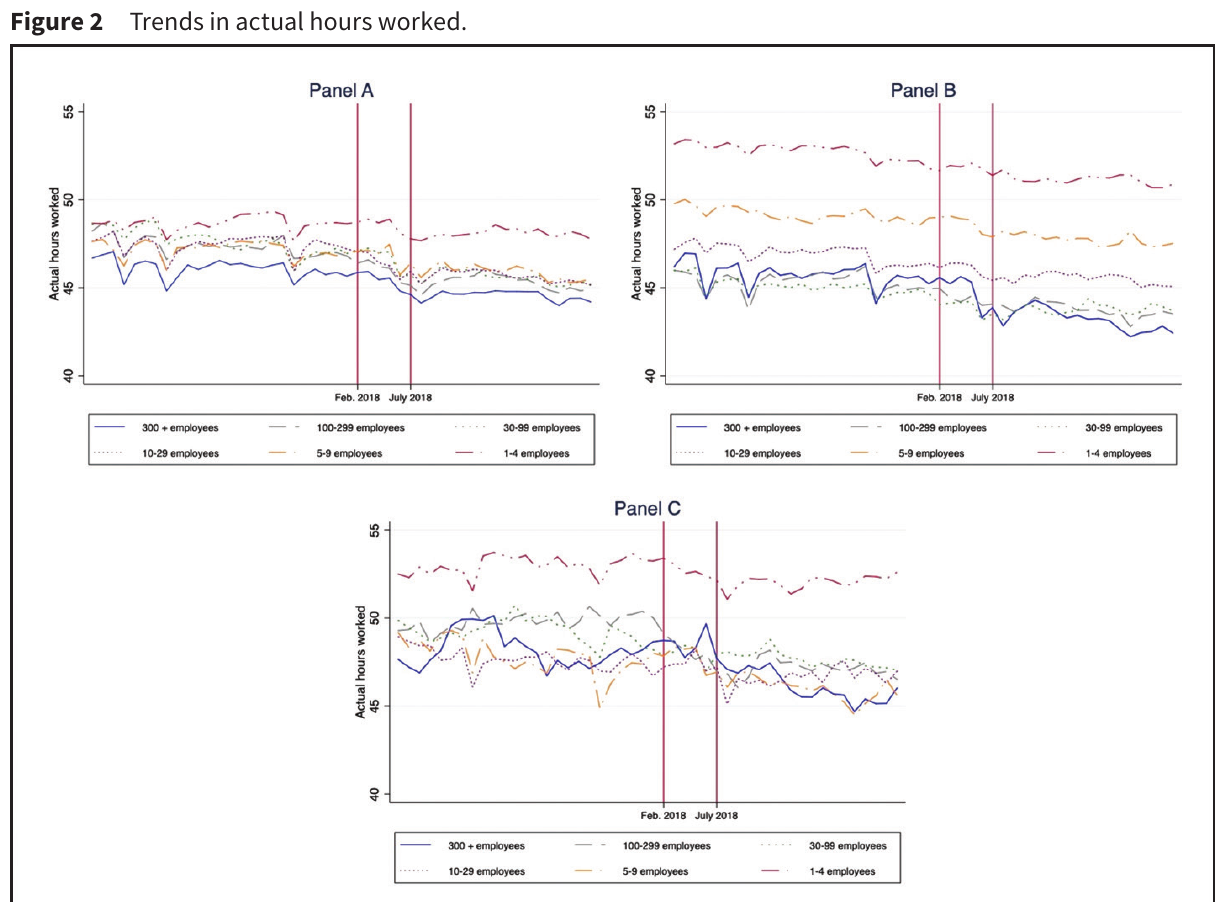
Figure 2 Trends in actual hours